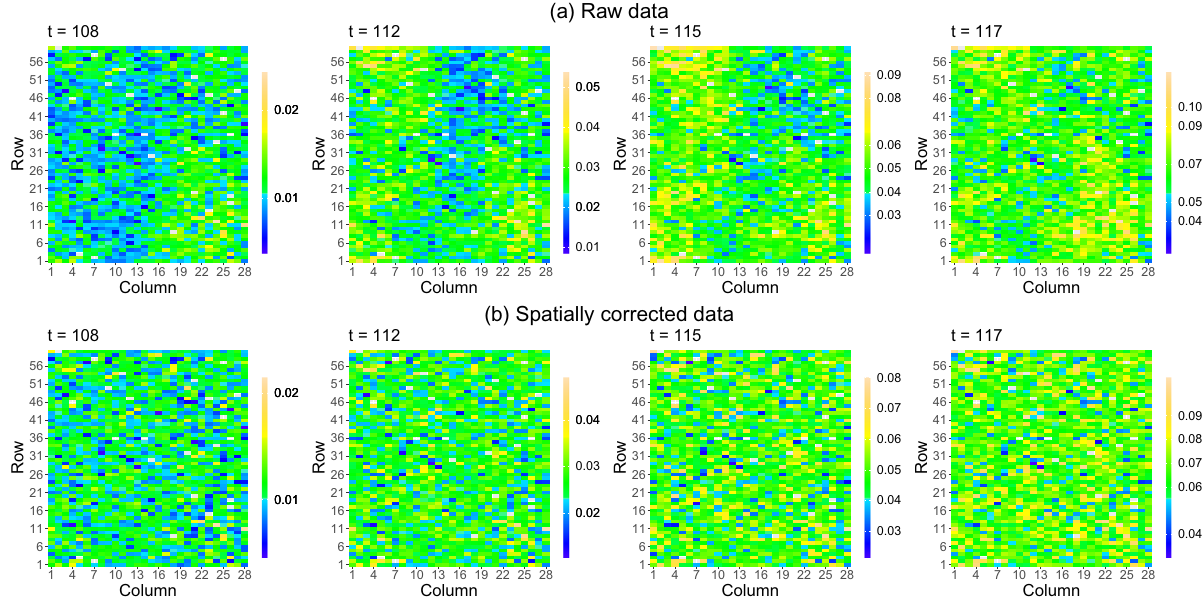
Figure 2. Results of the first stage of analysis for the PhenoArch platform: Spatial distribution of the ( a ) raw and ( b ) spatially corrected leaf area at four different measurements times ( t = 108, 112, 115, 117 DOY). The white areas denote missing data. The colour scale is different for each time